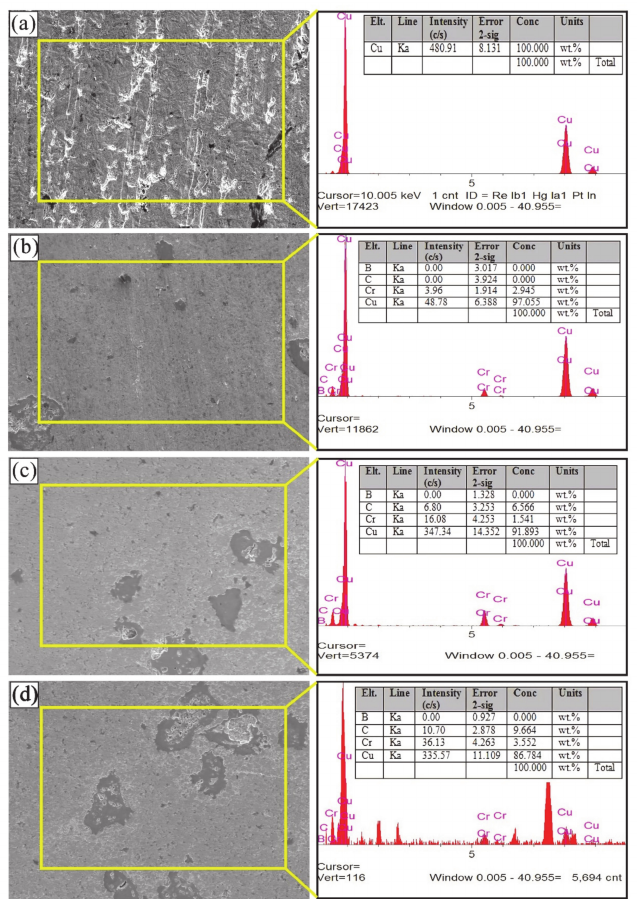
Figure 5. SEM-EDX micrographs of composites produced at different ratios: ( a ) pure sample, ( b ) 2.5 wt.% B-CrC, ( c ) 5 wt.% B-CrC, ( d ) 7.5 wt.%